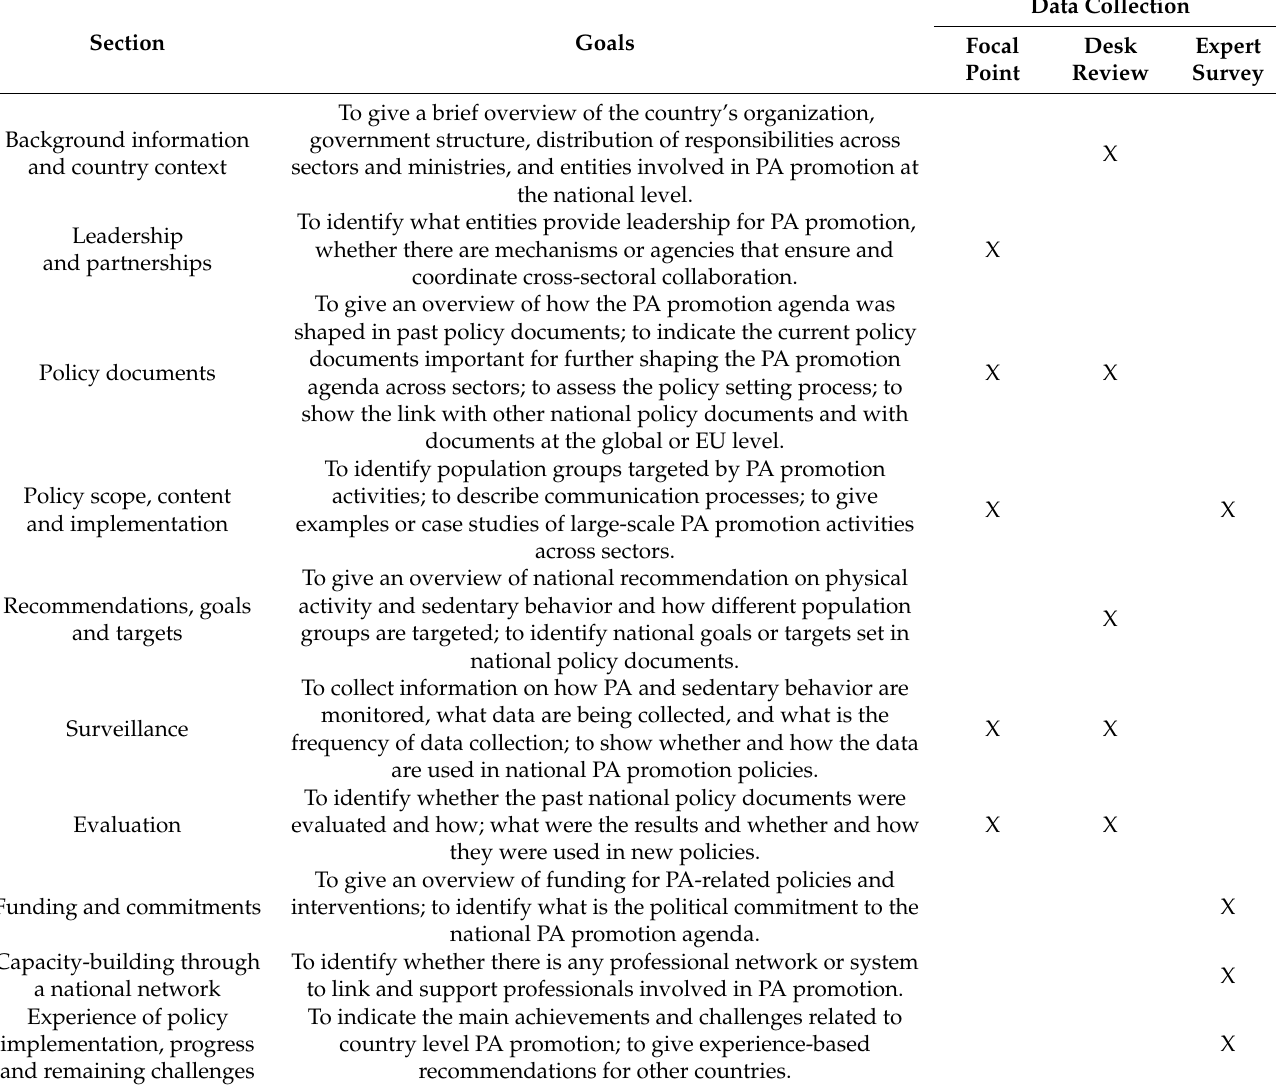
Table 1. The overview of the HEPA PAT structure.